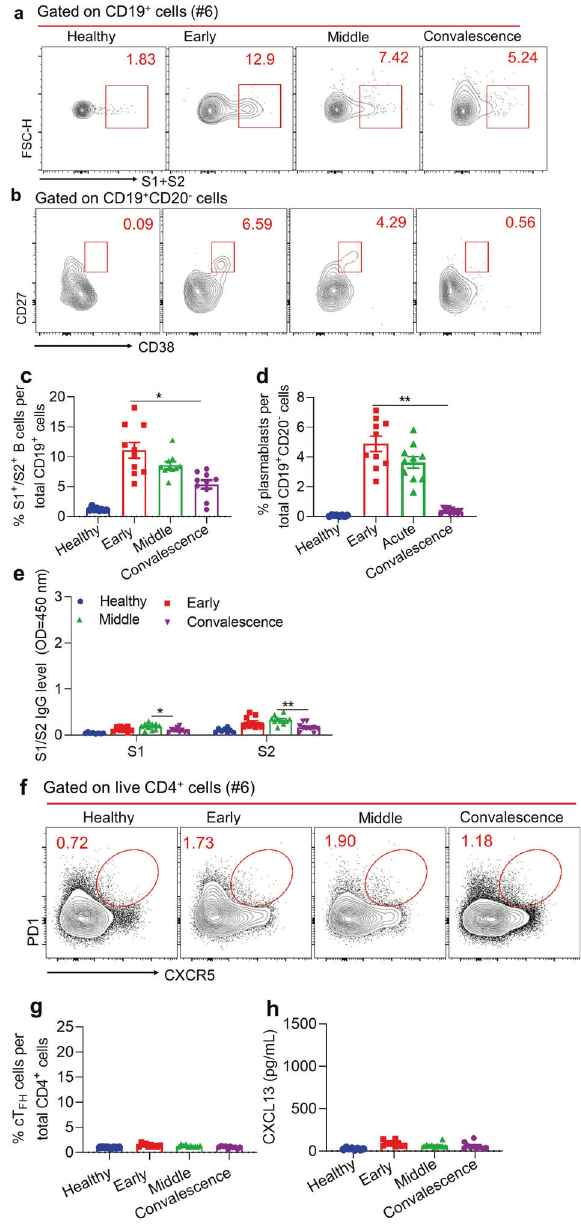
Fig. 3 Kinetics of virus-speci fi c B cell responses to SARS-CoV2 in COVID-19 Asymptomatic patients. Sample of a, b and f was from Asymptomatic (#6). a , b FACS plot examples of SARS-CoV2 S1- or S2- speci fi c B cells and plasmablasts (CD19 + CD20 - CD27 hi CD38 hi ) cells ’ percentage in early phase (0 – 3 days post hospitalization), acute phase (5 – 10 days post hospitalization), convalescent- phase, (more than 10 days after COVID-19 nucleic acid test shown negative) in the asymptomatic cohort. c , d Percentages of S1- or S2- speci fi c B cells ( c ), summarized from ( a ), and plasmablasts cells ( d ), summarized from ( b ), in the asymptomatic cohort. e Kinetics of S1- and S2- speci fi c IgG levels in asymptomatic patients ’ serum, measured by ELISA. f FACS plot examples of cT FH cells ’ percentage of asymptomatic patients. g Percentages of cT FH , summarized from ( f ). h Kinetics of CXCL13 level in asymptomatic patients ’ serum, measured by ELISA. Bars represent the mean ± SEM. P values were calculated based on Bonferroni of one-way ANOVA analysis. *** p < 0.0001, ** p < 0.001, and * p < 0.05